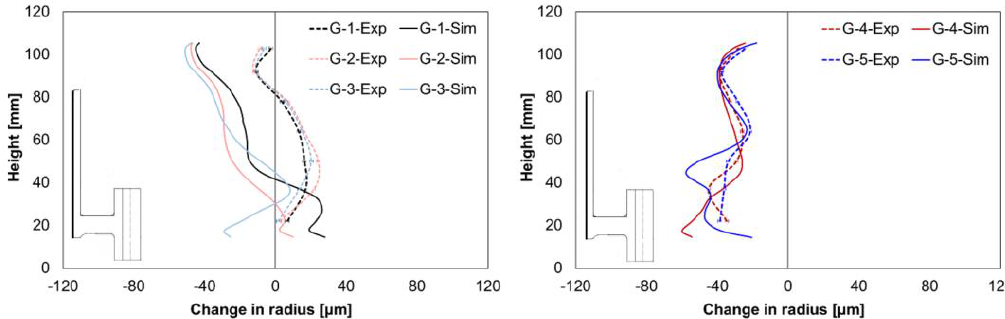
Figure 8. Comparison of measured and calculated radius changes at the hub inside for G1–G3 ( left ) and G4–G5 ( right ).